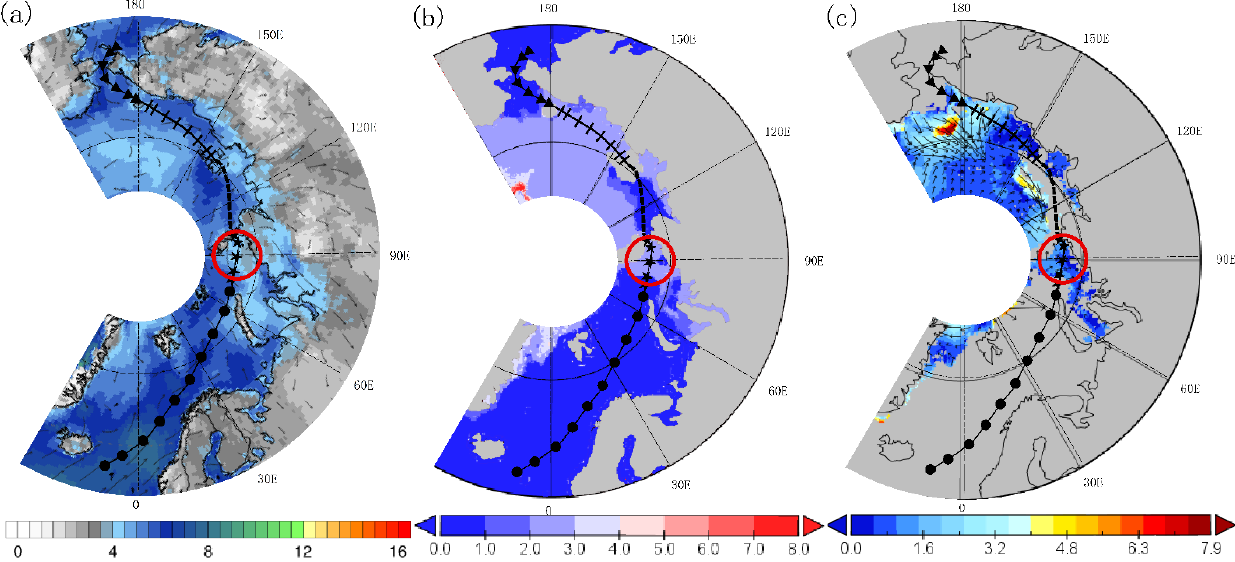
Figure 17. The average wind field ( a ), sea ice age ( b ) and sea ice movement ( c ) of the NEP in the Arctic in July 2013. J. Mar. Sci. Eng. 2021 , 9 , x FOR PEER REVIEW